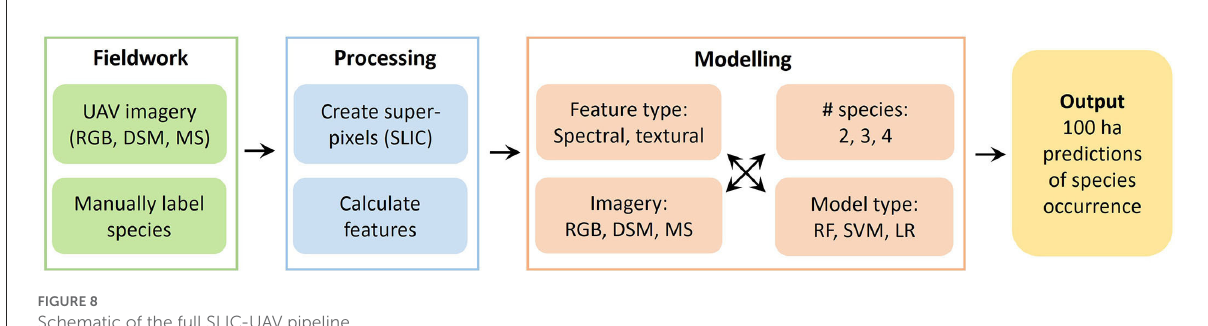
FIGURE8 Schematic of the full SLIC-UAV